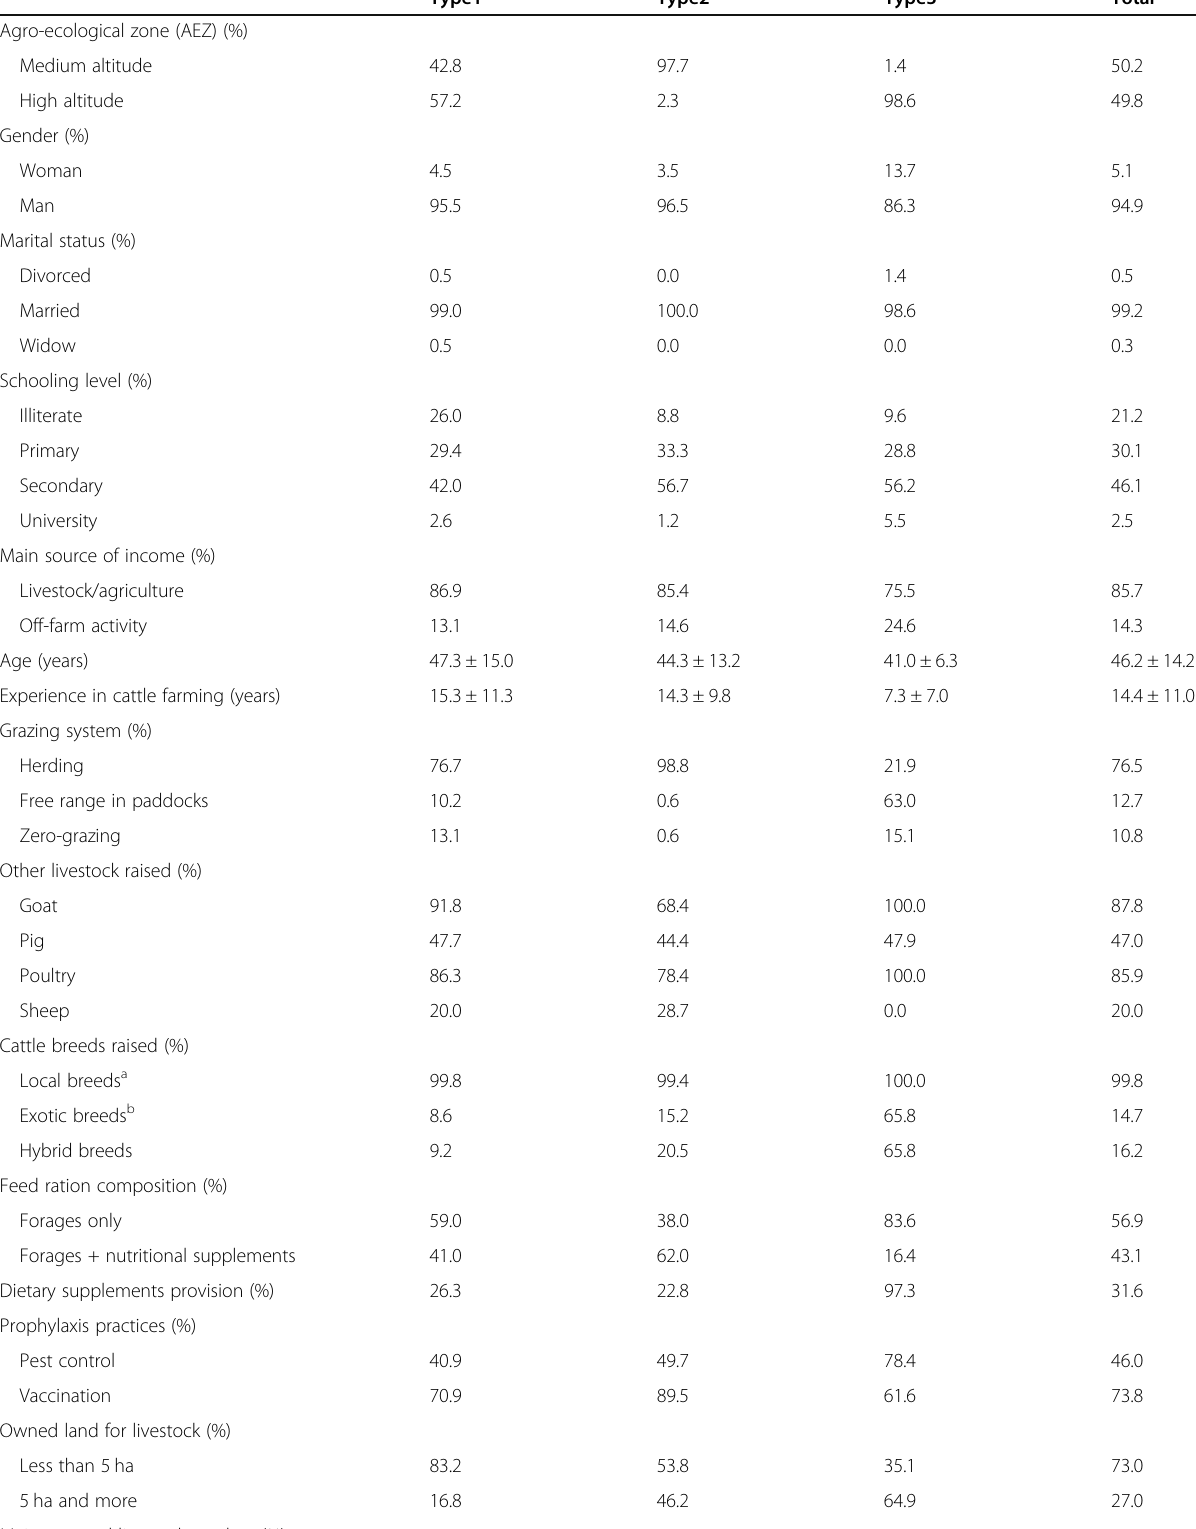
Table 2 Characteristics of cattle farm ’ s